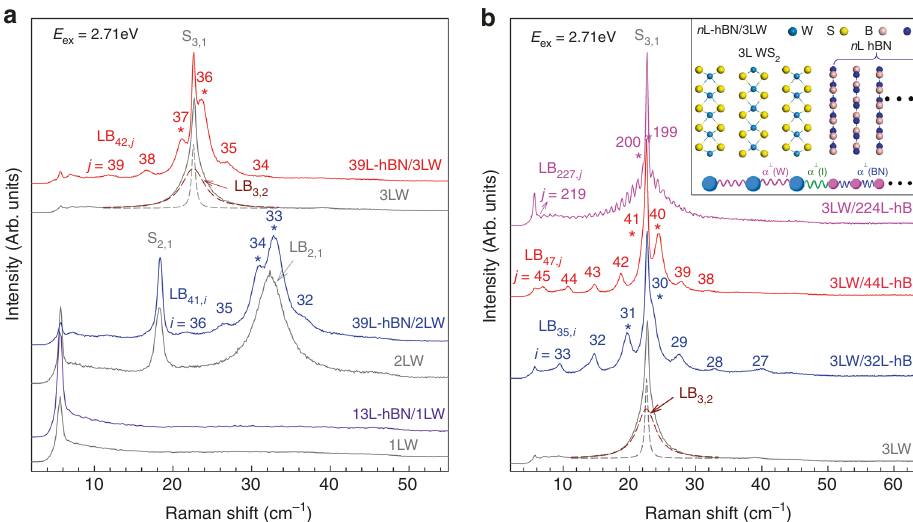
Fig. 2 Raman spectra of hBN/WS 2 and WS 2 /hBN with different numbers of WS 2 and hBN layers in vdWHs. a Raman spectra of 13L-hBN/1LW ( θ t = 17.4°), 39L-hBN/2LW ( θ t = 0.3°) and 39L-hBN/3LW ( θ t = 0.3°) along with the corresponding WS 2 fl akes. The dark red and dash pro fi le depicts the LB 3,2 mode in 3LW while the gray dash pro fi le represents the S 3,1 mode. b Raman spectra of 3LW/32L-hBN ( θ t = 23.5°), 3LW/44L-hBN ( θ t = 23.5°) and 3LW/224L-hBN ( θ t = 17.2°) along with the standalone 3LW fl ake. The spectra are scaled and offset for clarify. The stars represent the two prime LB modes in vdWHs. The inset in b shows the schematic diagram of the linear chain model for the LB modes in n